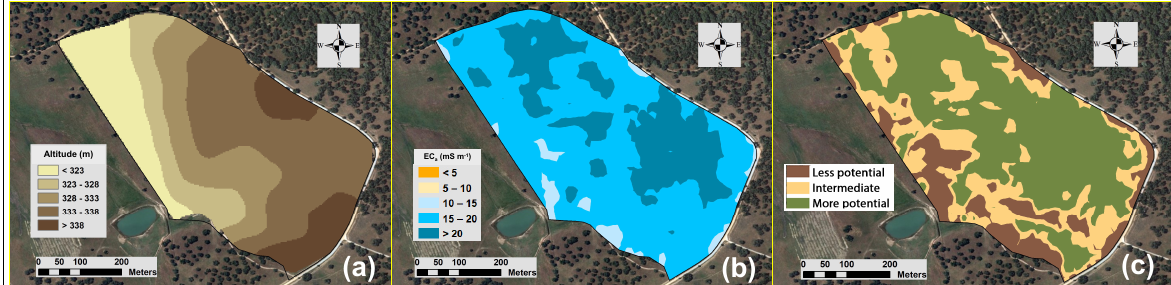
Figure 9. Altitude ( a ), soil apparent electrical conductivity (EC a ; ( b )) and homogeneous manage ‐ ment zones ( c ) of “Murteiras” experimental field.